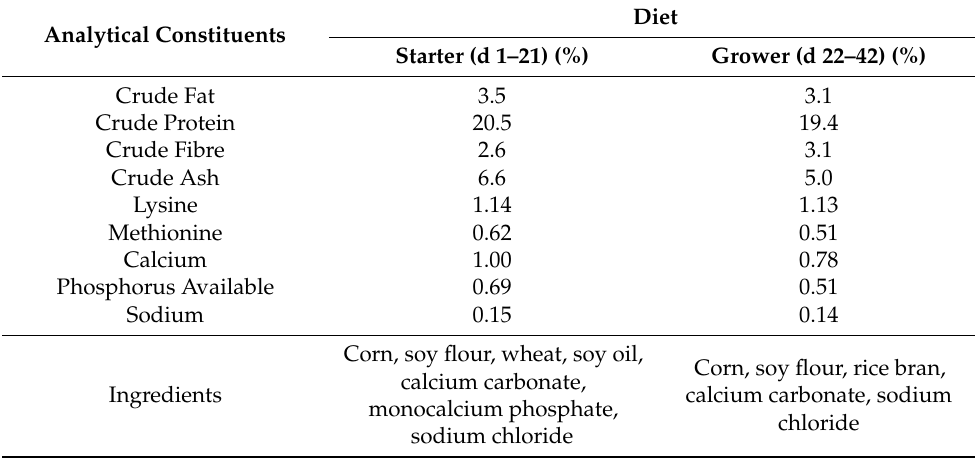
Table 1. Composition of starter and grower